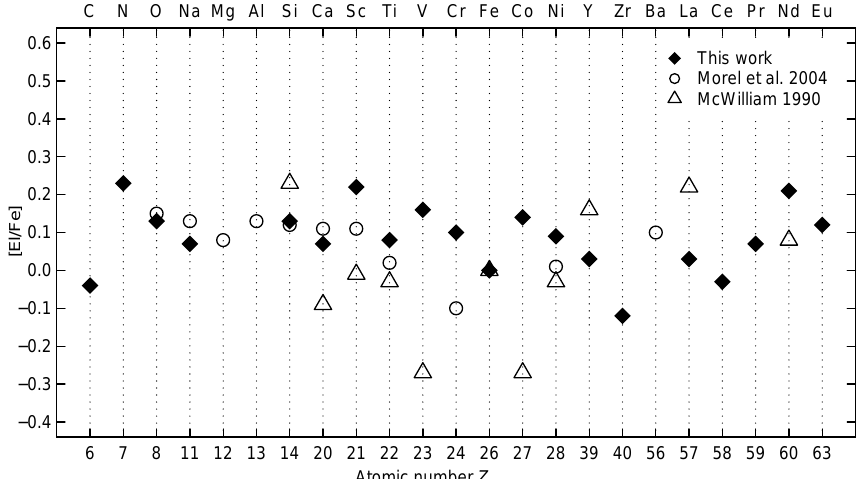
Fig. 8. Element abundances for 33 Psc, as determined in this work (filled dia- monds), by Morel et al. (2004, circles) and by McWilliam (1990, triangles).